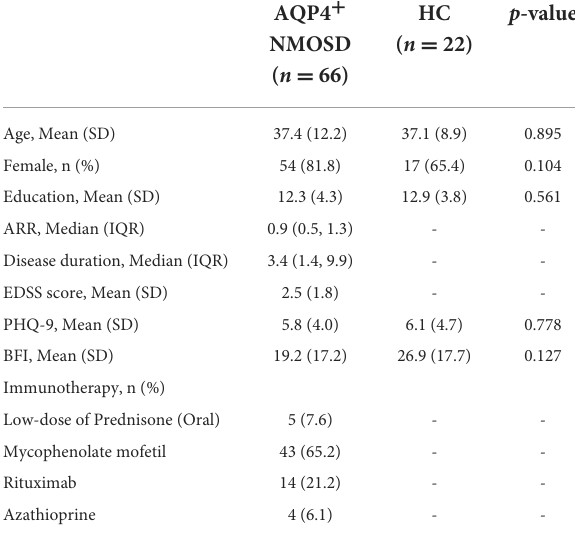
TABLE 1 Baseline characteristics of patients with NMOSD and healthy